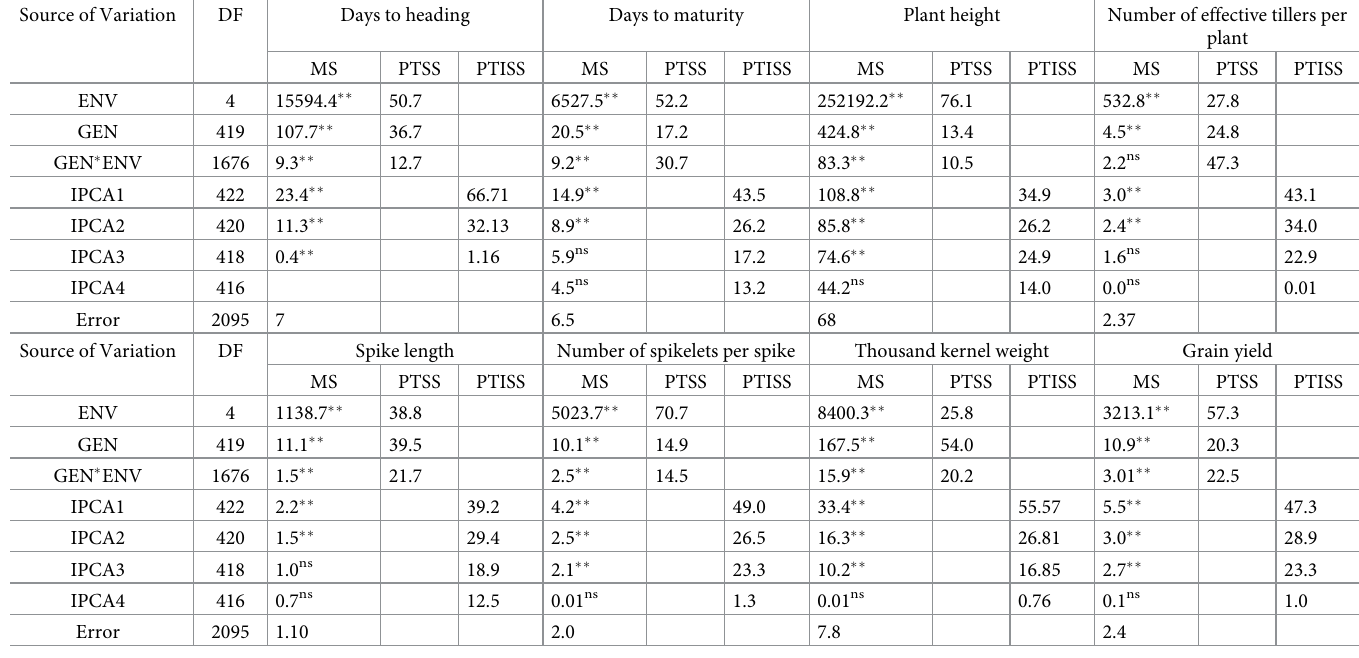
Table 3. Mean square (MS), percentage of the total sum of squares (PTSS) from AMMI analysis of variance for eight traits in 420 Ethiopian durum wheat genotypes grown in five environments, and percentage of total interaction sum of squares (PTISS) of the interaction principal components (IPC). Source of Variation